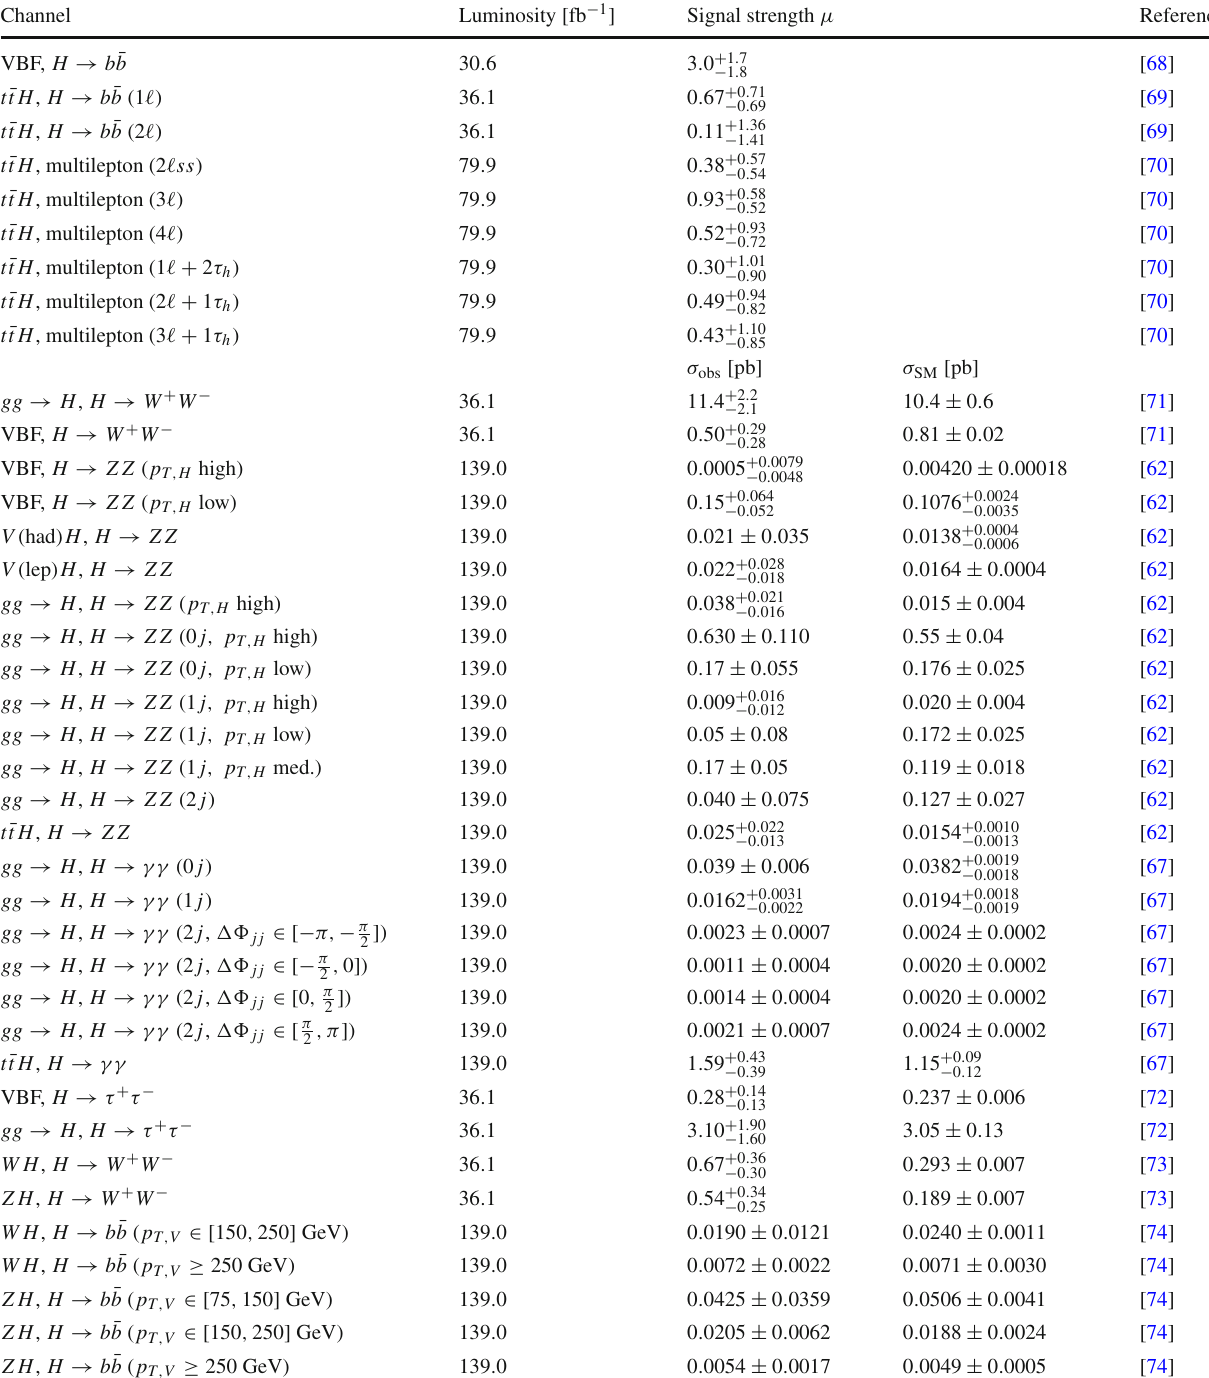
Table6 ATLASHiggsratemeasurementsfromLHCRun-2includedinthedefaultobservableset LHC13_Apr2020 in HiggsSignals-2.6.0 Channel Luminosity [fb − 1 ] Signal strength